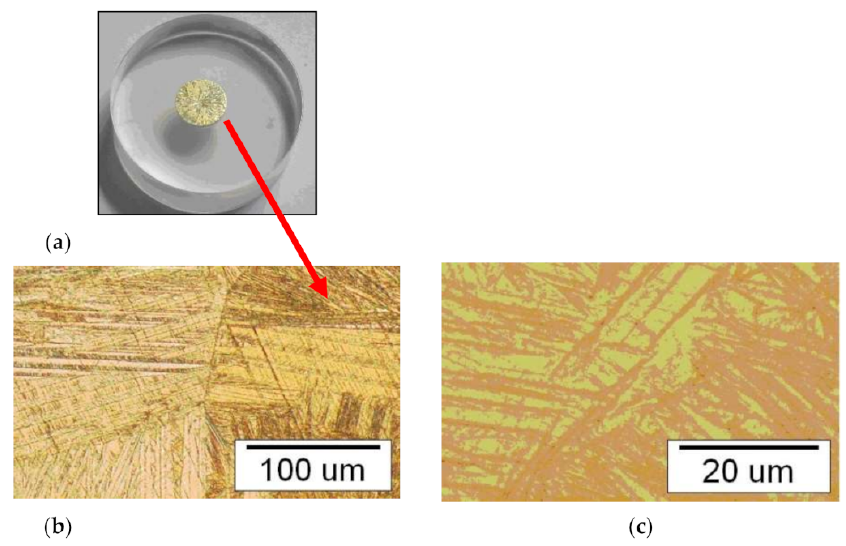
Figure 3. CuAlNI alloy: ( a ) Cross-section of the testing sample, ( b , c ) typical